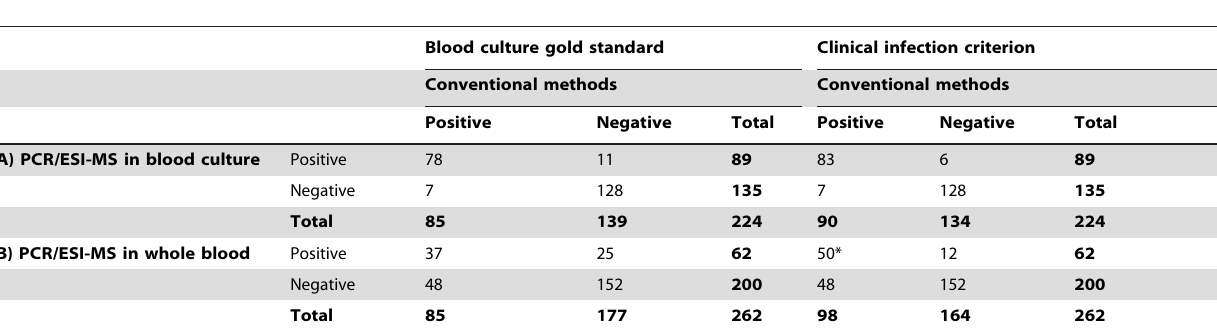
Table 1. Agreement between microorganisms isolated by conventional microbiological methods and detected by the PCR/ESI-MS method according to the gold standard used and the specimen